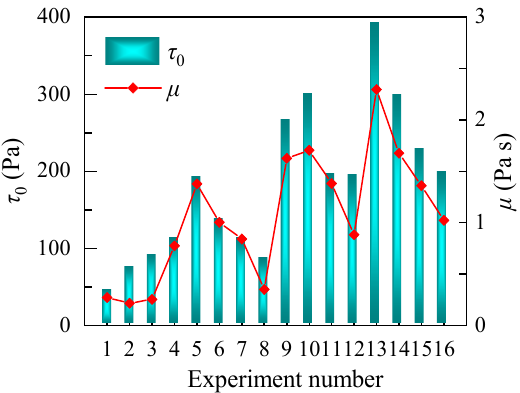
Figure 3. Variation in rheological properties of the orthogonal experiment.